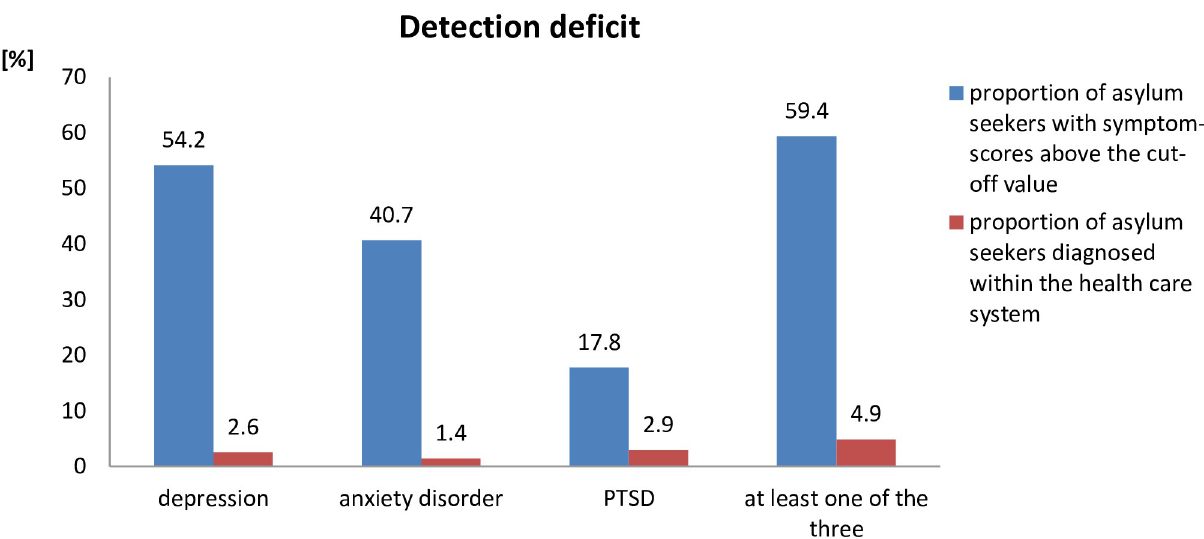
Fig 1. Comparison of the proportions of asylum seekers with psychological complaints in the cross-sectional study and in the outpatient health care system. The difference between the bars signals a detection deficit.